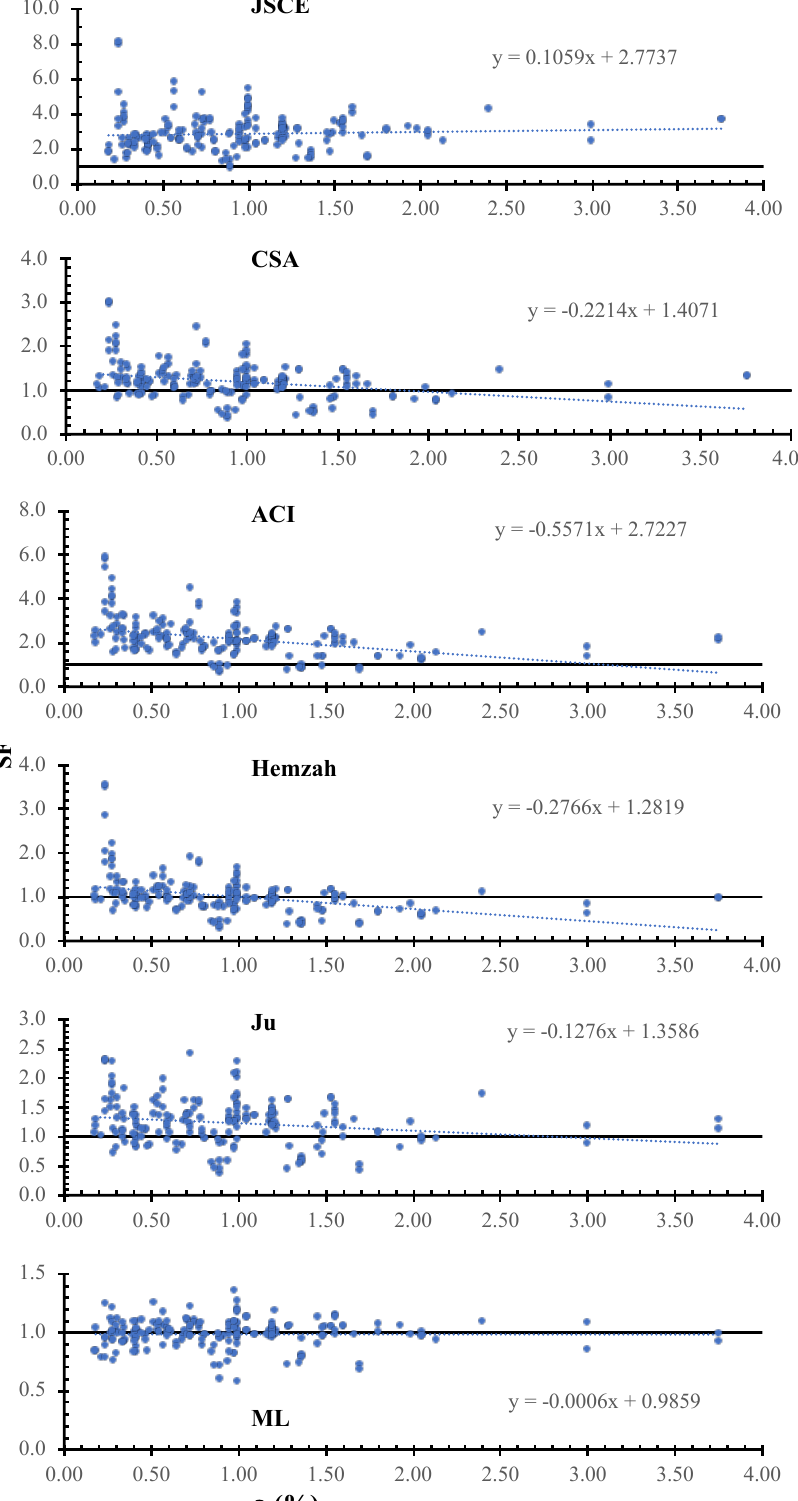
Figure 10. SF calculated using various models versus ρ